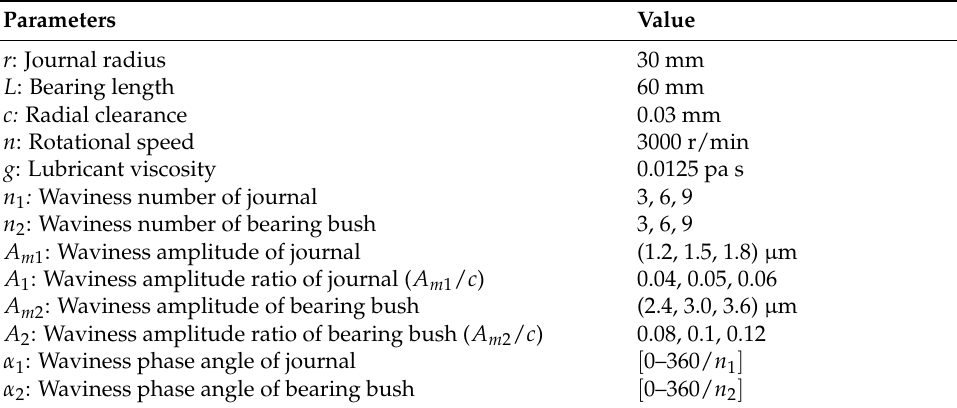
Table 2. Dimensionless bearing (cid:48) s parameters of the present study.